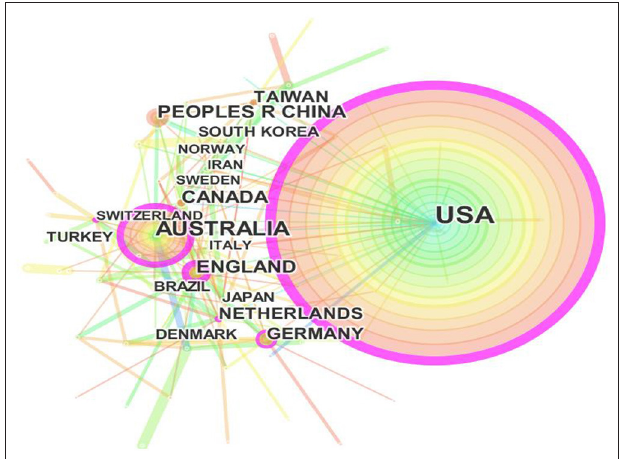
FIGURE 3 | Visualization on main research countries in health literacy research.